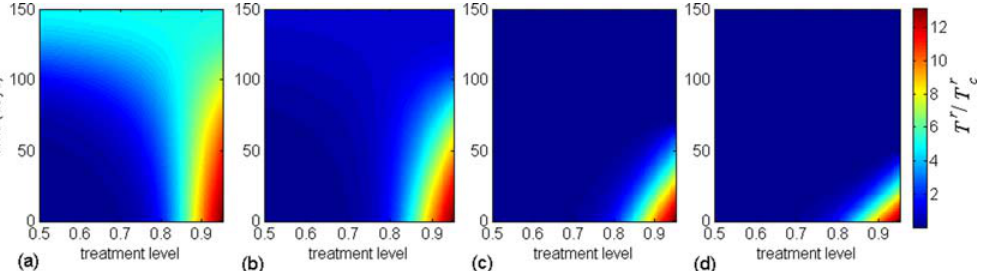
Figure 6. The effect of changing treatment level during a pandemic on the total number of clinical infections caused by the high ~ 1 : 6 . Simulations were seeded with an initial treatment level of (a) 85%; (b) 78% (optimal level); (c) 50%; (d) 25%, fitness resistant strain, with R w 0 and then changed to the level shown on the horizontal axis at the time displayed on the vertical axis (corresponding to the time-course of the epidemic). The color bars illustrate the total number of clinical infections due to the resistant strain with high transmission fitness, relative to that generated when the optimal constant treatment level (78% in this case) is implemented.